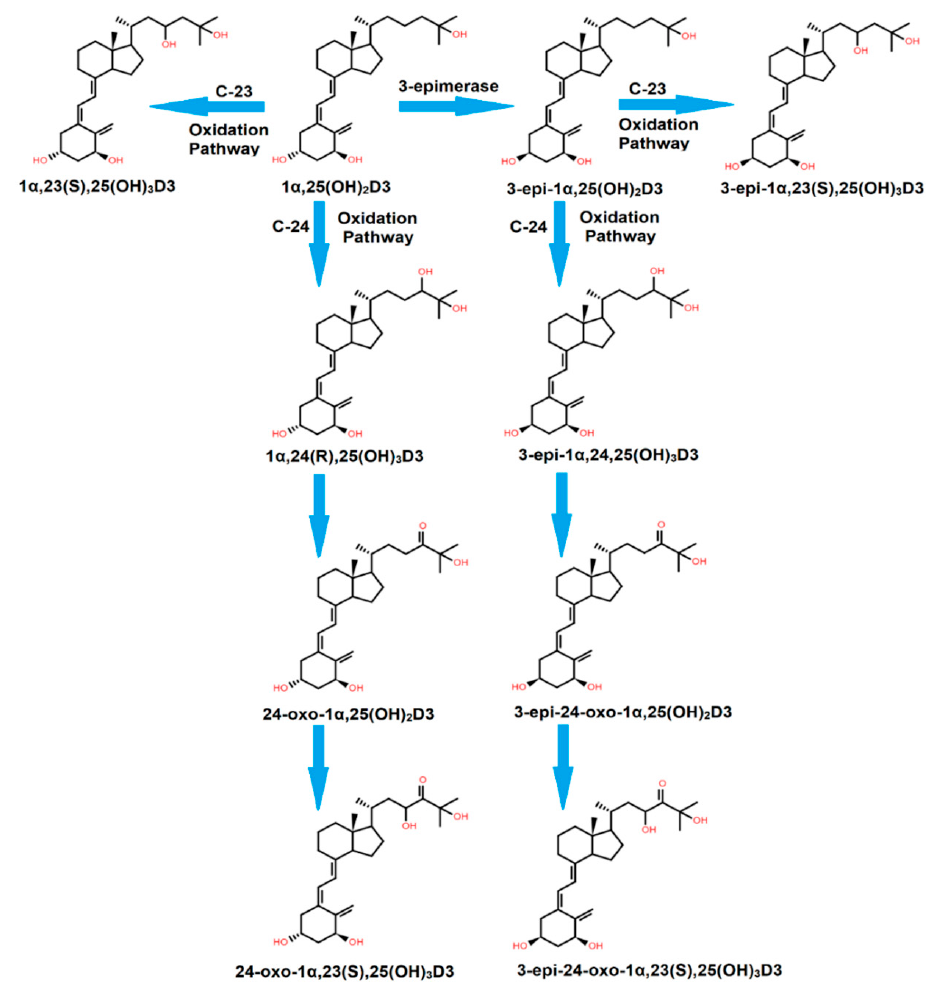
Figure 2. The C-23 and C-24 oxidation pathways for 1 α ,25(OH) 2 D3 and its epimer.